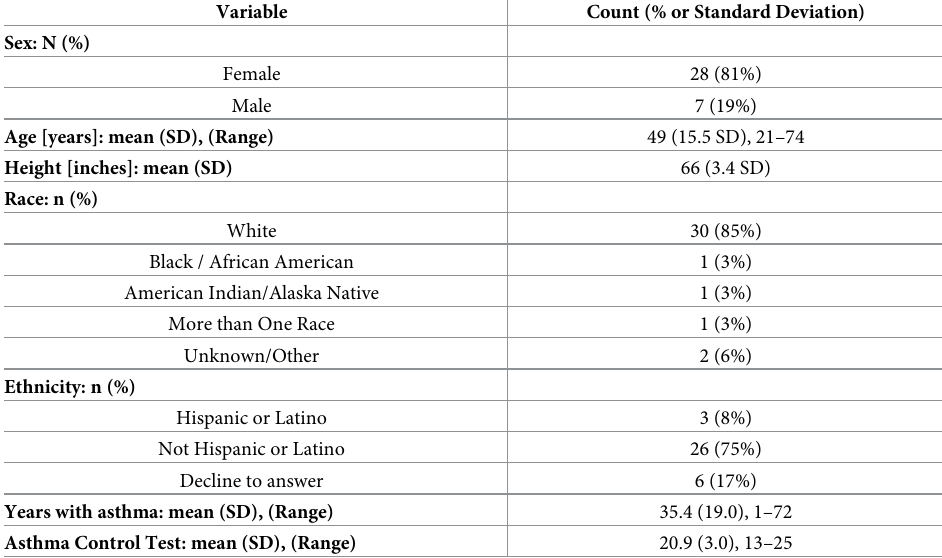
Table 1. ELF participant demographic information.